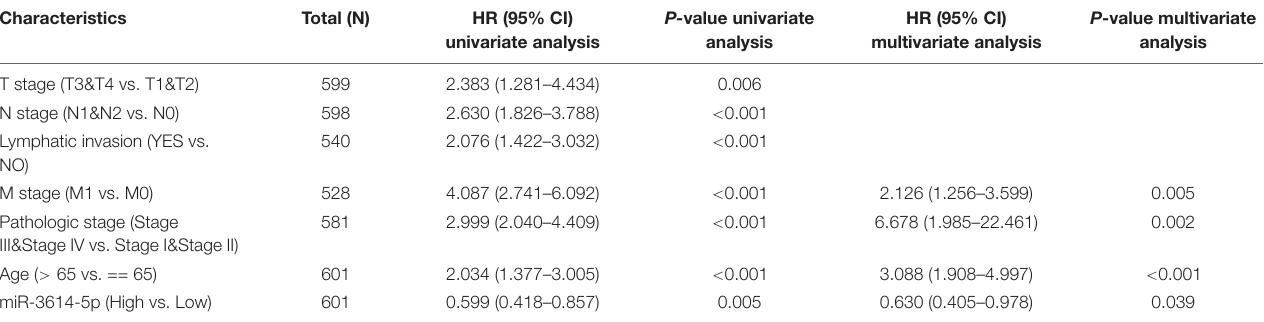
TABLE 3 | Univariate and multivariate Cox proportional hazards regression analysis of miR-3614-5p expression. Characteristics Total (N)